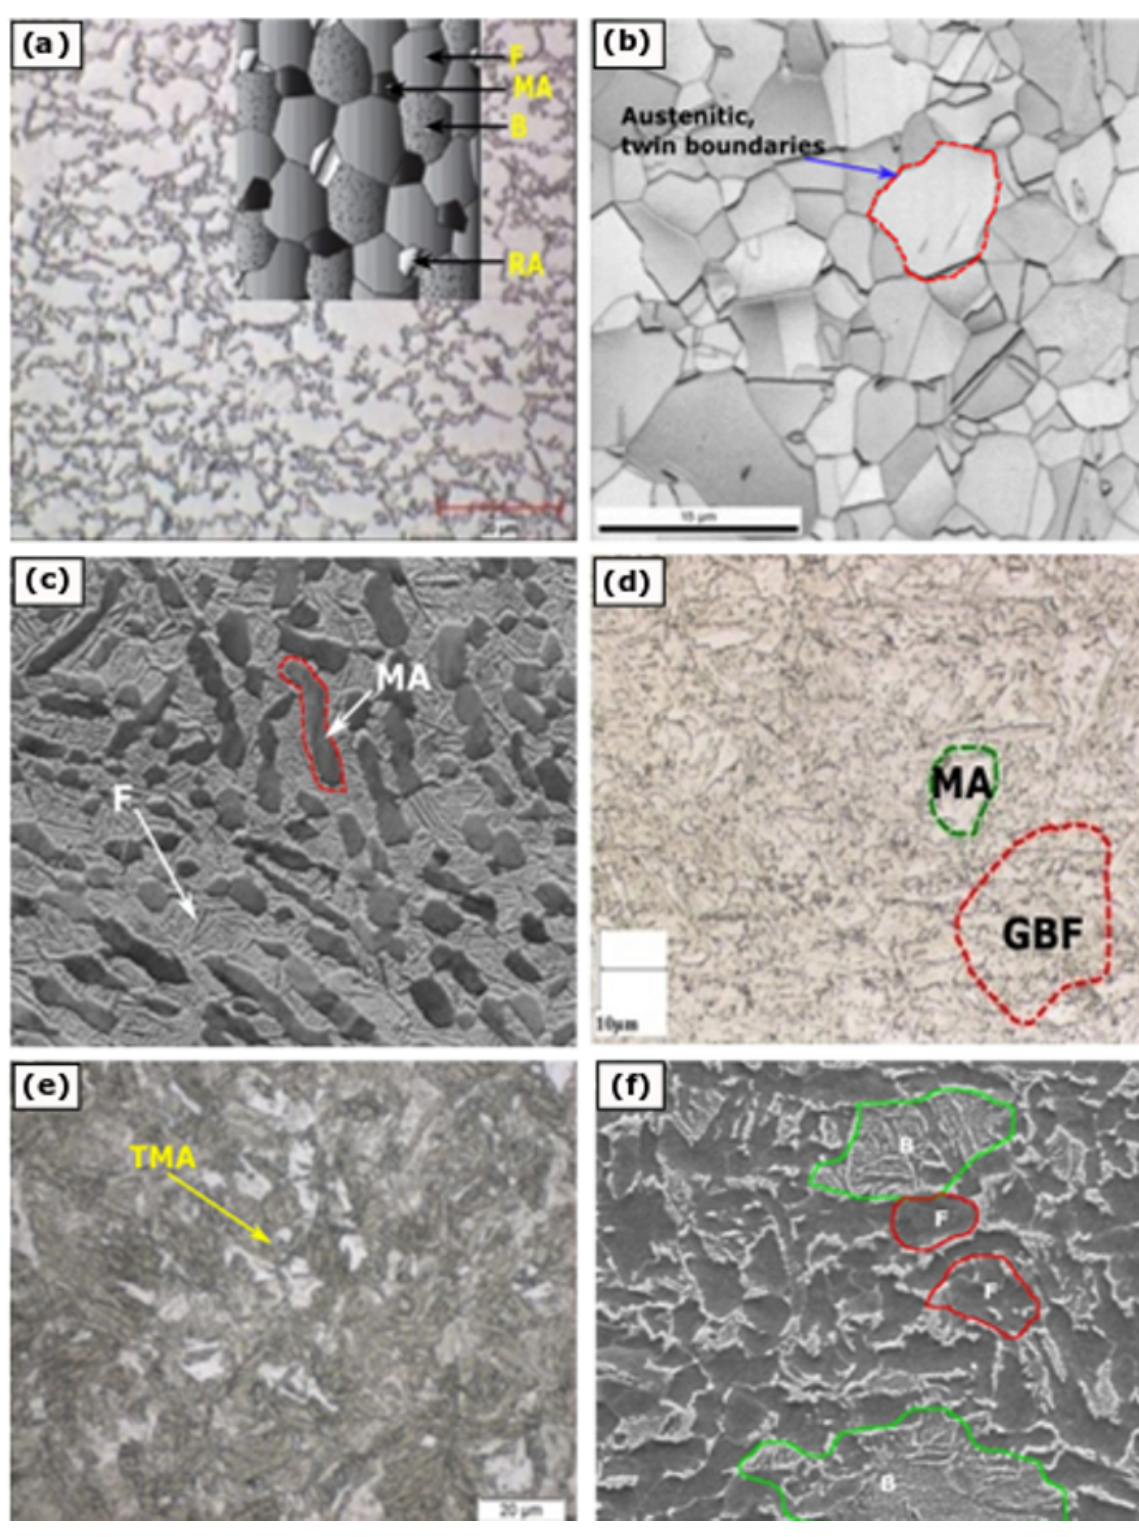
Figure 2: Microstructure UHSS and AHSS; (a) microstructure of TRIP 690 steel, (b) microstructure of TWIP steel, (c) microstructure of DP steel, (d) microstructure of CP 800/1000 steel, (e) microstructure of MS 950/1200 steel, and (f) The microstructure of FB 450/600 steel [16,